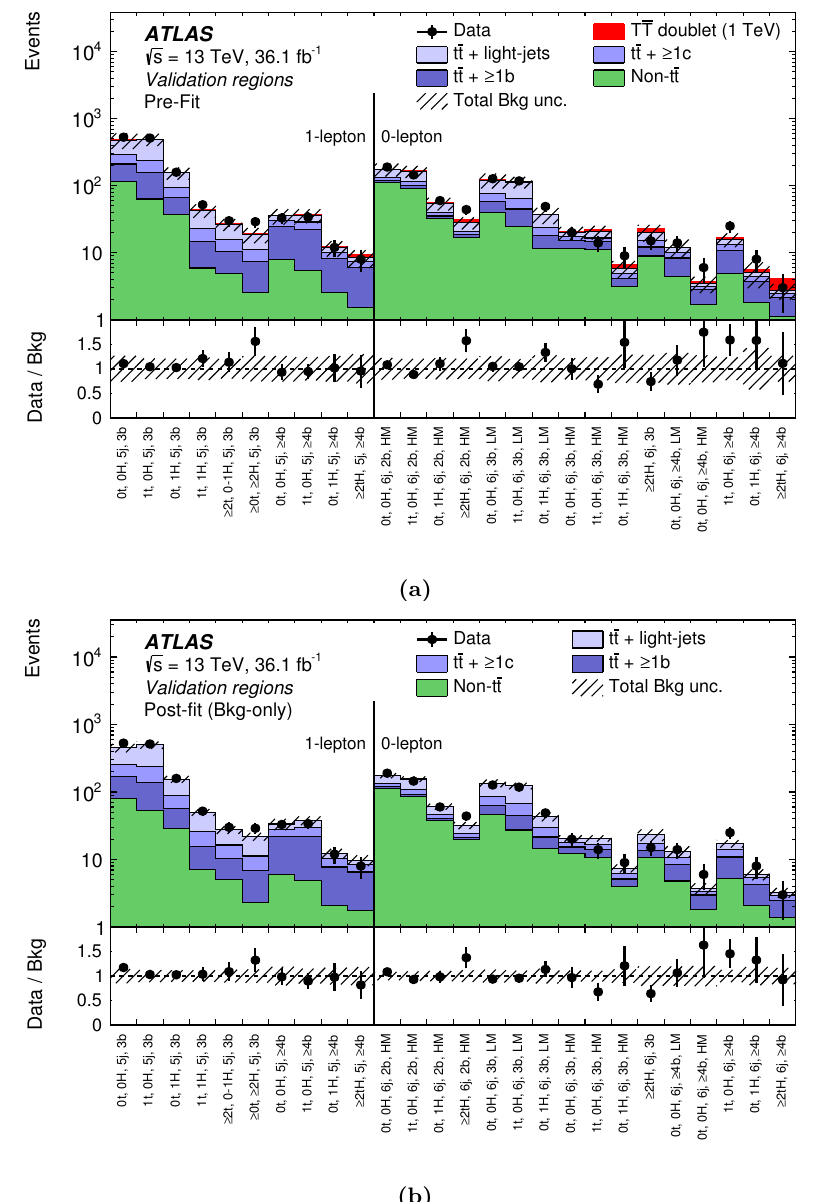
Figure 14. Comparison between the data and background prediction for the yields in each of the validation regions considered in the 1-lepton and 0-lepton channels (a) before the (cid:12)t (\Pre-(cid:12)t") and (b) after the (cid:12)t (\Post-(cid:12)t"). The (cid:12)t is performed on the data in 1-lepton and 0-lepton channels under the background-only hypothesis considering only the search regions. In the pre-(cid:12)t (cid:12)gure the expected T (cid:22) T signal (solid red) corresponding to m T = 1 TeV in the T doublet scenario is also shown, added on top of the background prediction. The small contributions from t (cid:22) tV , t (cid:22) tH , single-top, W=Z +jets, diboson, and multijet backgrounds are combined into a single background source referred to as \Non- t (cid:22) t ". The bottom panels display the ratios of data to the total background prediction (\Bkg"). The hashed area represents the total uncertainty of the background. In the case of the pre-(cid:12)t background uncertainty, the normalisation uncertainty of the t (cid:22) t + not included.